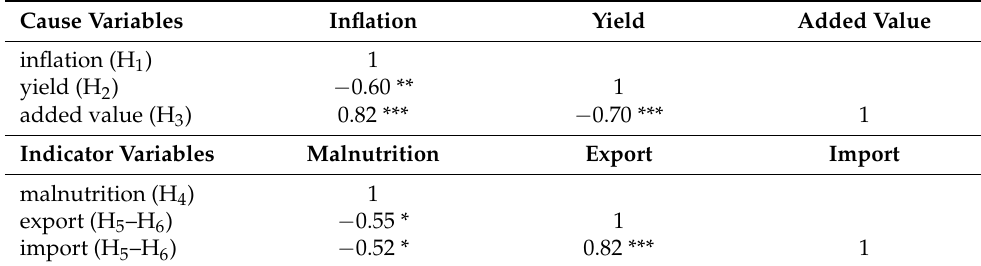
Table 2. Correlation matrix of the